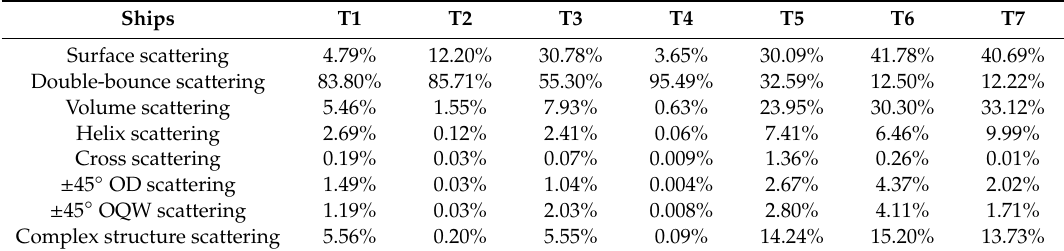
Figure 6. Decomposition results for ships T1 to T7 in the first to seventh rows, respectively. ( a , b ) Color composite results generated from the double-bounce (red), volume (green), and surface scattering (blue). ( c , d ) Color composite results generated from the complex structure (red), volume (green), and surface scattering (blue). Table 2. Scattering contribution statistics for